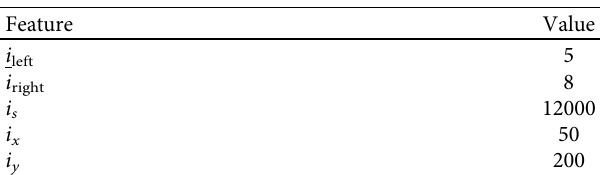
Table 1: Correction factor